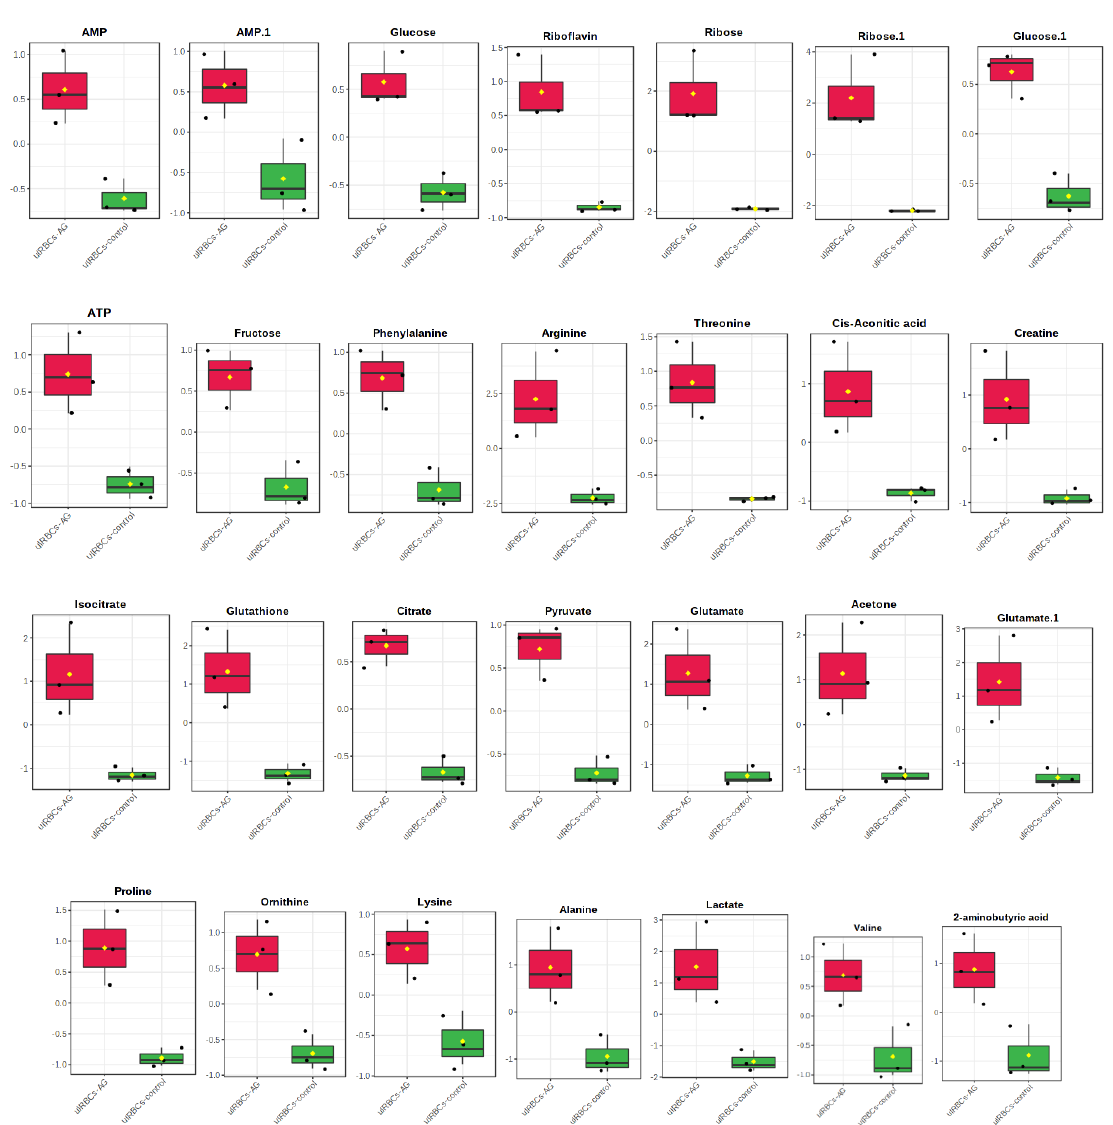
Figure 10. Box plots of the relative quantities of the significant metabolites of uRBCs-AG (red color) and uRBCs-control (green color) using 1 H-NMR spectra binned data with a VIP value ≥ 0.1 in OPLS-DA model. uRBCs, uninfected red blood cells; AG, andrographolide.